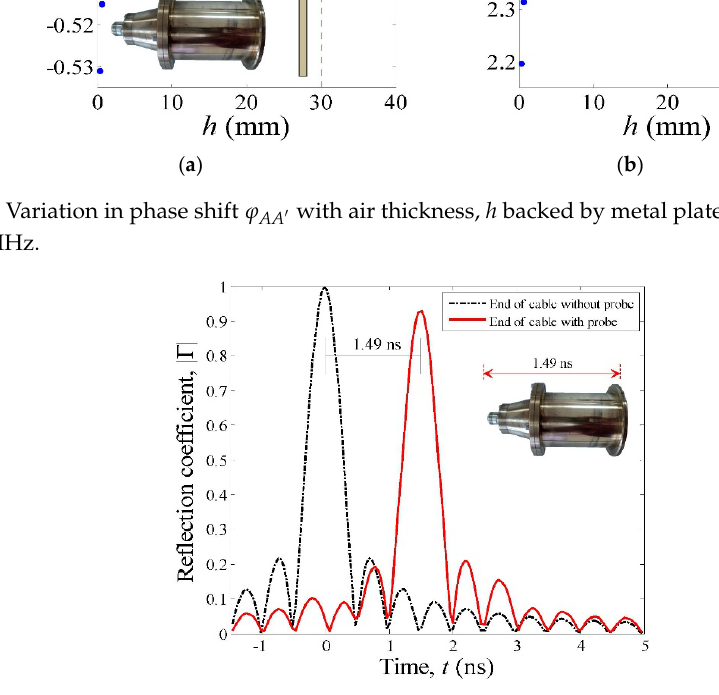
Figure 4. The time-domain response for the end of cable at plane-AA ′ with and without probe.